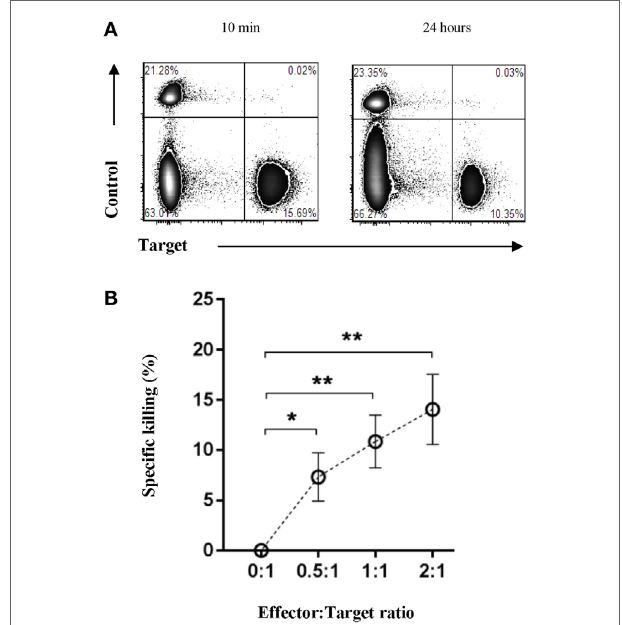
FigUre 6 | The Oncopig immune system specifically lyses autologous tumor cells in vitro . Oncopigs were subcutaneously injected with AdCre to induce tumor formation. Following tumor development (7–21 days post injection), tumor cells and PBMCs were harvested. Isolated effector cells remained unlabeled with control cells and tumor cells being labeled with eFluor670 or eFluor450, respectively. (a) Representative flow cytometric plots of control and tumor cells at 10 min (baseline, left plot) and 24 h (right plot) post coculture. (B) Numbers represent percentage specific killing of autologous tumor cells; data were normalized to adjust for cell turnover in no-effector cells control cultures. A titration of the effector:target cell ratio is shown. Data are pooled from four independent experiments ( n = 8). Bars represent mean values ± SEM. Statistical evaluations were performed by paired Student’s t -test (* P < 0.05 and ** P <